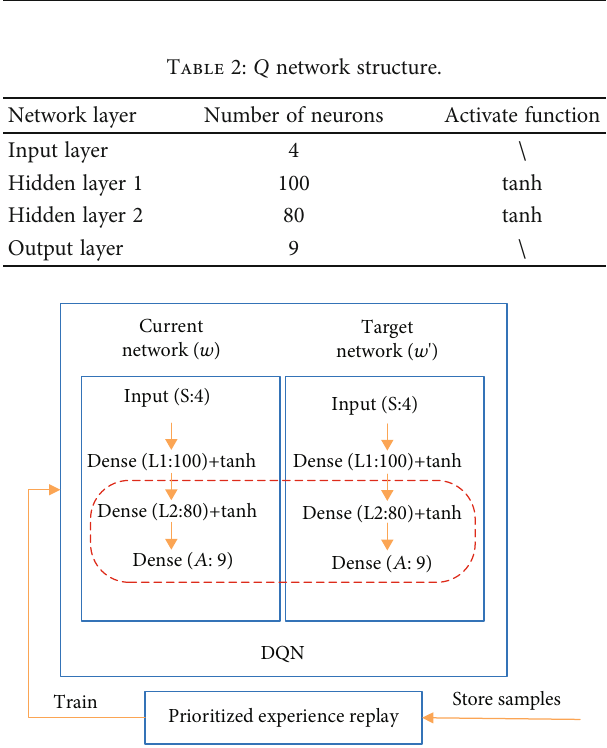
Figure 5: The structure of DQN network. Table 3: DQN algorithm hyperparameter.